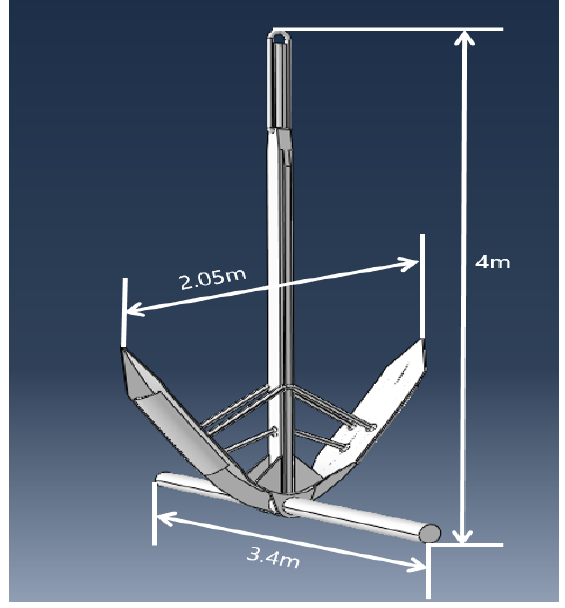
Figure 9. Dimensions of the stow net anchor (AGM anchor).